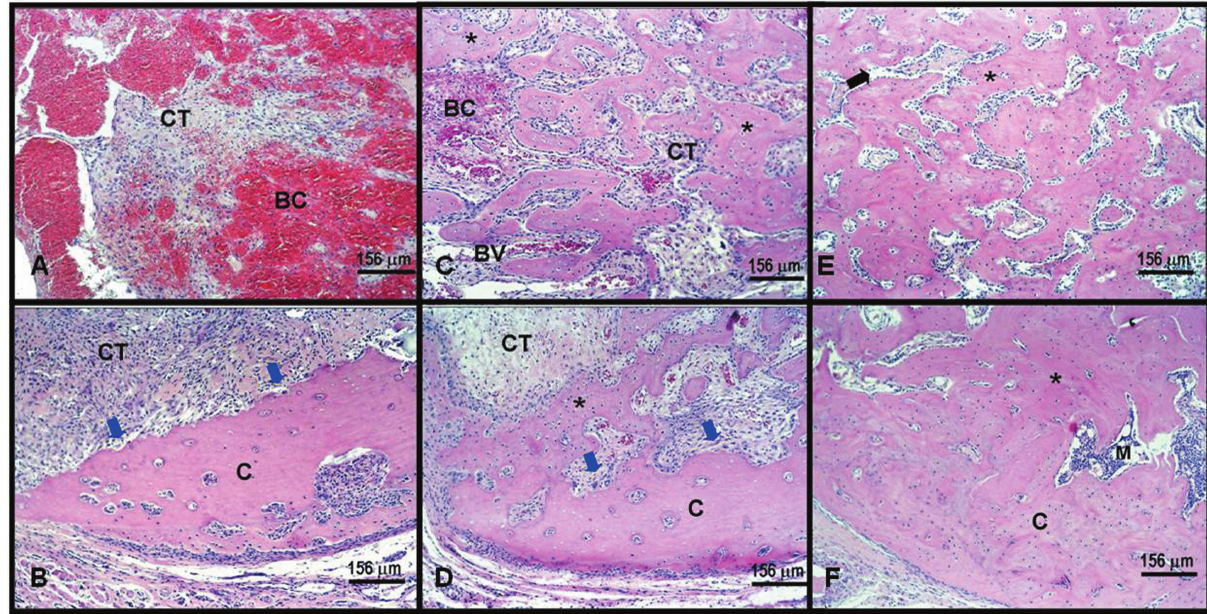
Figure 3- Non-infected rats present normal alveolar wound healing. Histological longitudinal specimens of Group I: 6 days postoperative (A and B) showing blood clot (BC) and connective tissue (CT) filling the cervical portion of socket (A); and buccal cortical plate resorption (blue arrows) in (B); 15 days postoperative (C and D) showing rich vascularized connective tissue (CT), bone (asterisk) and blood clot (BC) in (C); new bone formation (asterisk), buccal cortical plate resorption (blue arrows) surrounded by connective tissue (CT) in (D); 28 days postoperative (E and F) displaying thick bone trabeculae (asterisk) and medular spaces surrounding the bone trabeculae.